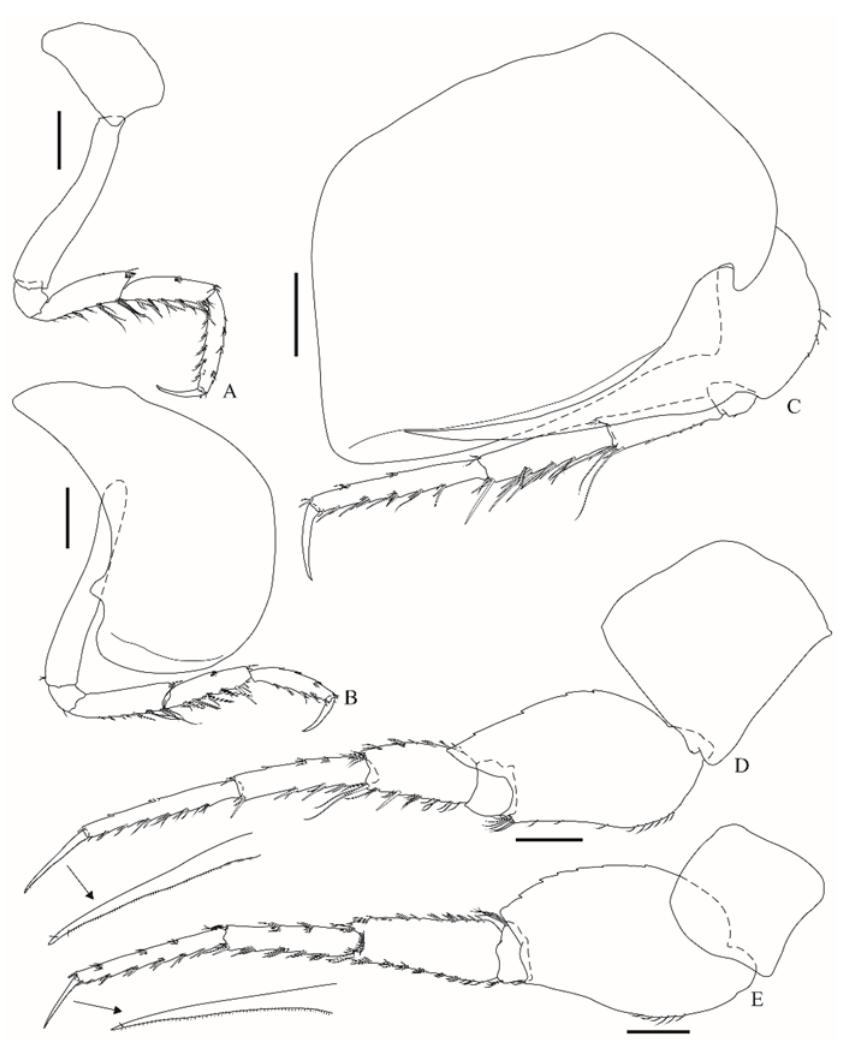
Figure 5. Cyphocaris boecki sp. nov., female holotype, 33.3 mm (MOUFPE 20068). ( A – E ) Pereopods 3 – 7, respectively. Scale bars: 1